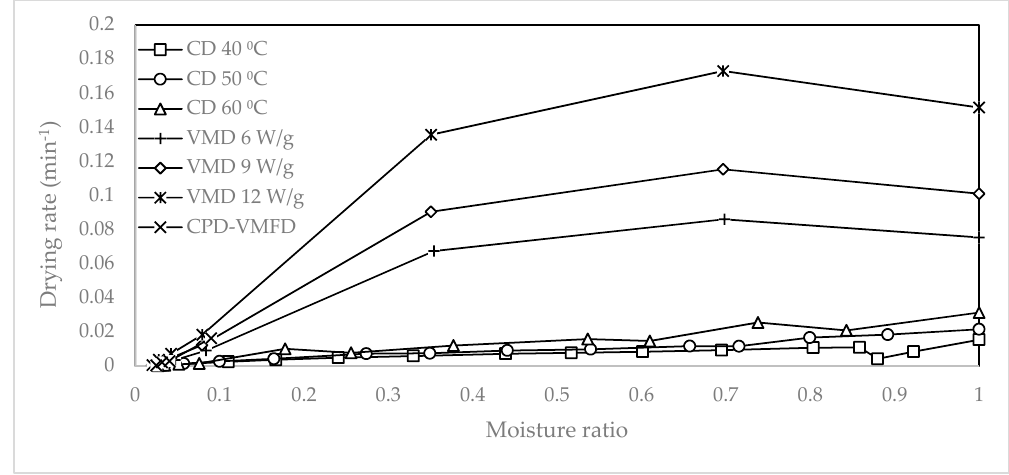
Figure 2. The relationship between drying rate and moisture ratio for the drying of S. crispus with CD at 40, 50, and 60 ◦ C, VMD at 6, 9, and 12 W / g, and CPD-VMFD at 50 ◦ C and 9 W / g. The maximum drying rates observed for VMD at 6, 9, and 12 W / g were 0.086, 0.115, and − 1 ◦ ◦ ◦ 0.173 min , respectively. In CD at 40 C, 50 C, and 60 C, the maximum drying rates were